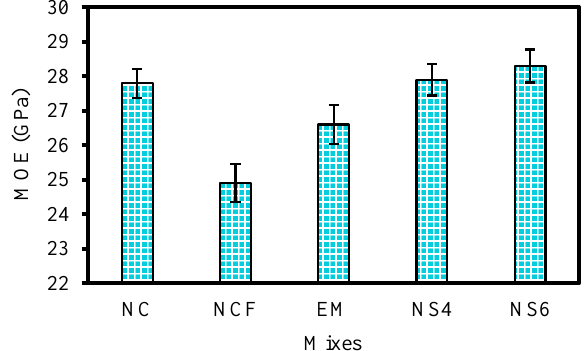
Figure 11. Modulus of elasticity of the designed mixes.